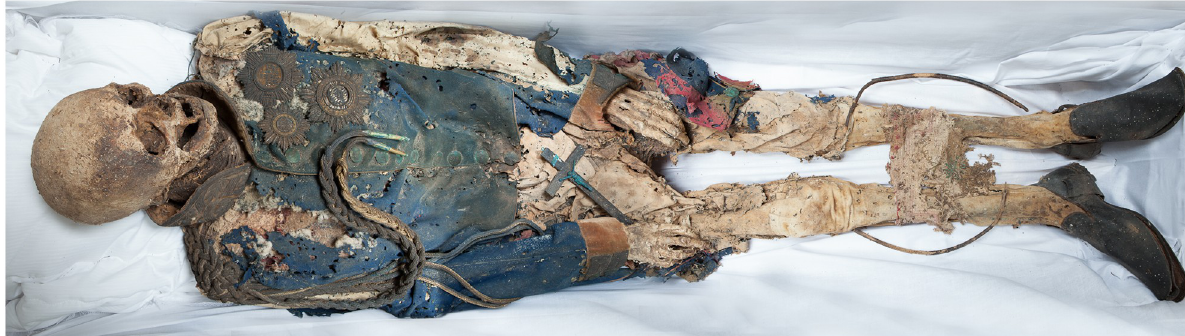
Fig 2. The mummy of General Count Heinrich LII. Reuss-Ko¨stritz in his sarcophagus (after finishing the investigation).